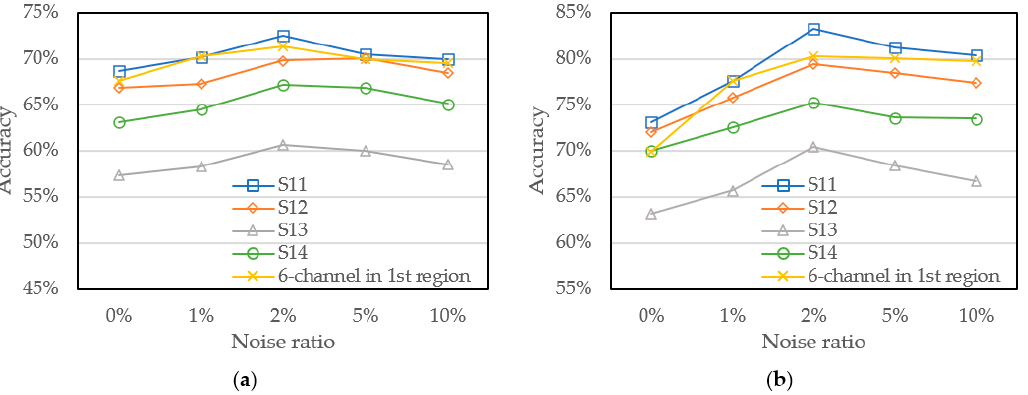
Figure 9. Model accuracy trained with different dataset and noise addition ( a ) GridsearchCV ( b ) Bayesian optimization.